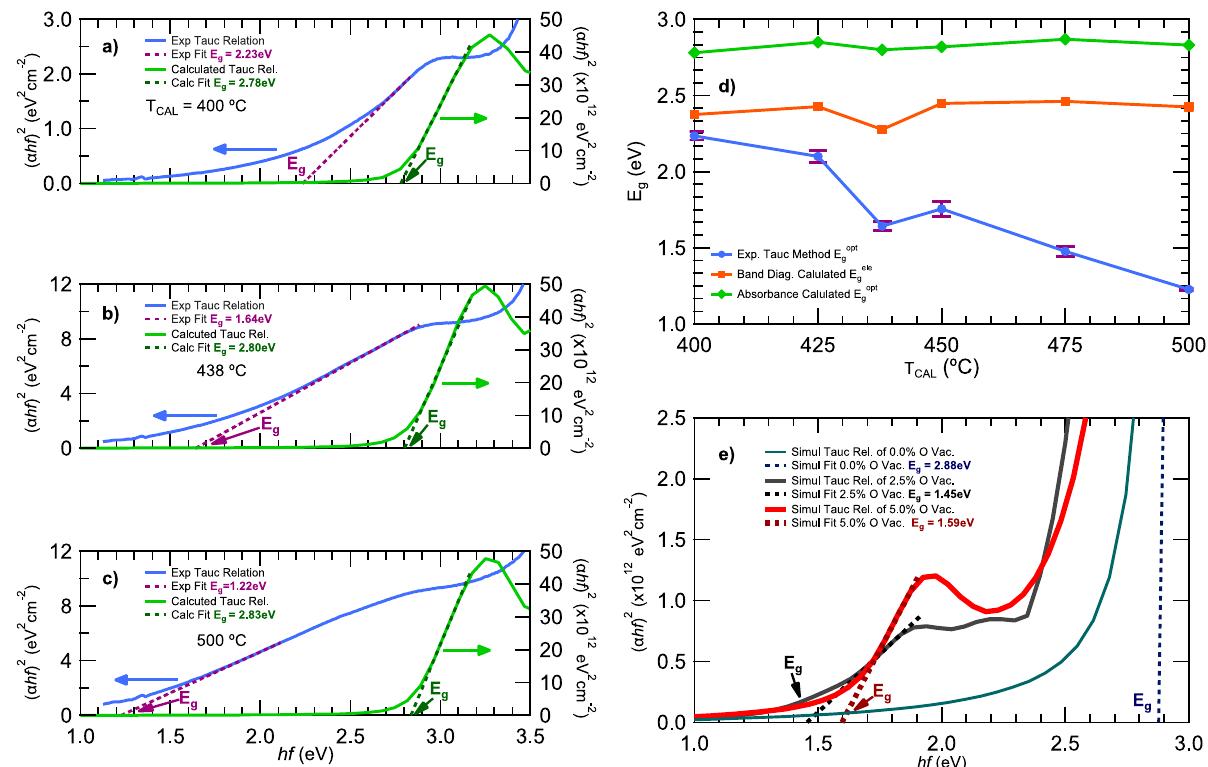
Figure 2. Optical properties obtained from the Tauc plot method and DFT calculations. ( a – c ) Comparison of Tauc plot relations obtained experimentally and plots calculated using DFT. ( d ) Experimental and ab initio optical band gap (from the Tauc plot method) and electronic band gap (calculated from DFT) as functions of T CAL . ( e ) Tauc plots simulated with 2.5% and 5.0% oxygen-deficient systems. Experimentally, the band gap reduces when increasing T CAL and DFT calculations with the Rietveld-refined structures do not fully reproduce this trend. However, when including oxygen vacancies, the band gaps calculated are closer to the experimental